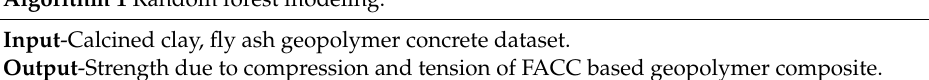
Algorithm 1 Random forest modeling.